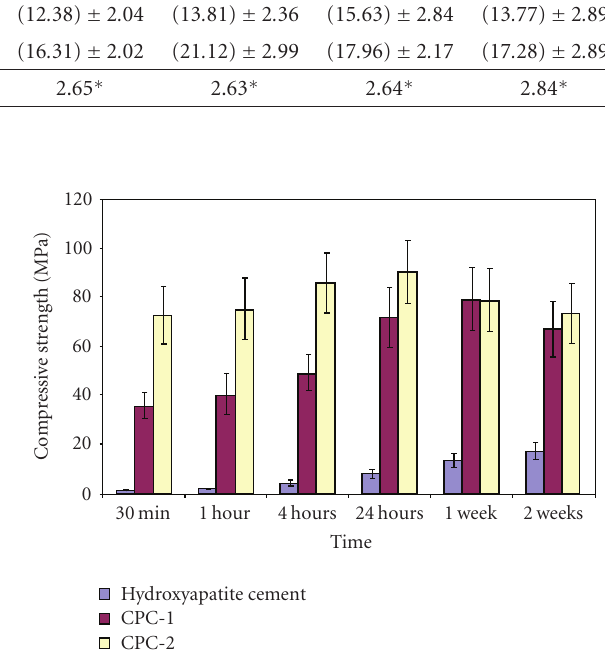
Figure 2: Histogram showing the mean compressive strength of hydroxyapatite cement and the two polymeric CPCs